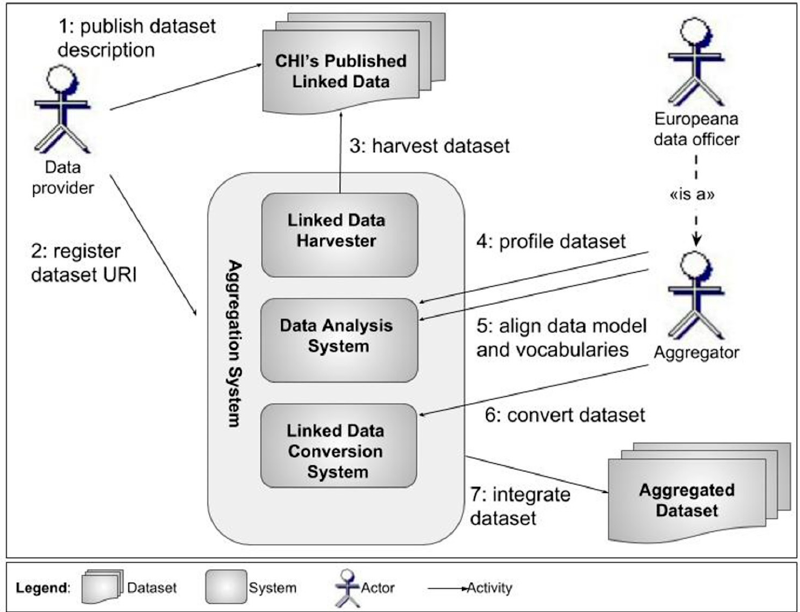
Figure 3. Overview of the linked data aggregation workflow for cultural heritage.